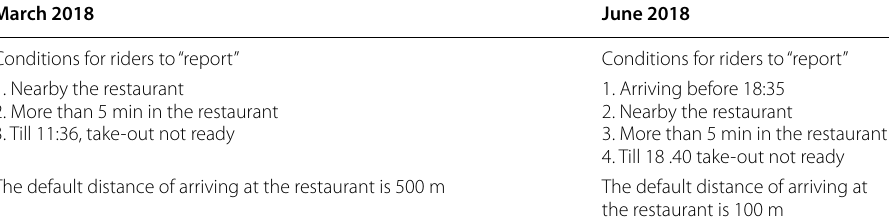
Table 2 Before and after changes of conditions for riders to